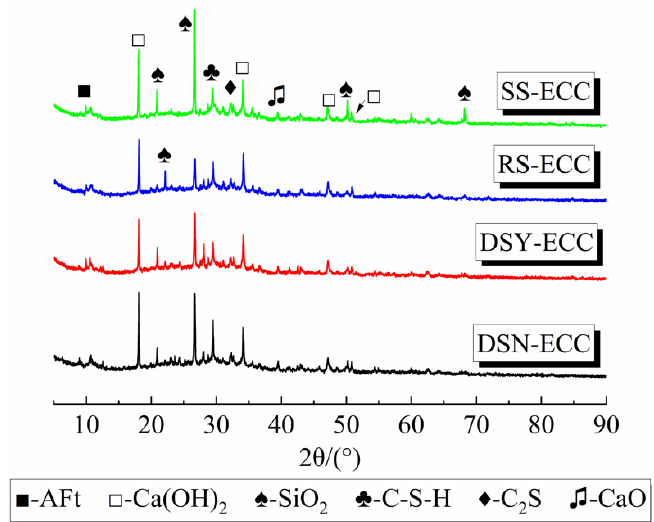
Figure 7. XRD patterns of hydrate of ECC under different fine aggregates.